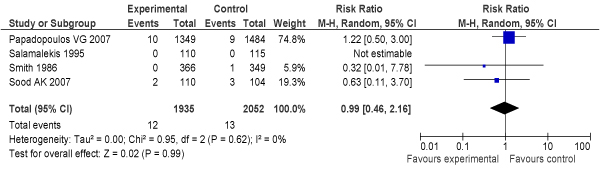
Meta-analysis (Forest plot, Random effects model) of impact of vibroacoustic stimulation versus mock or no stimulation on intrauterine or perinatal deaths.